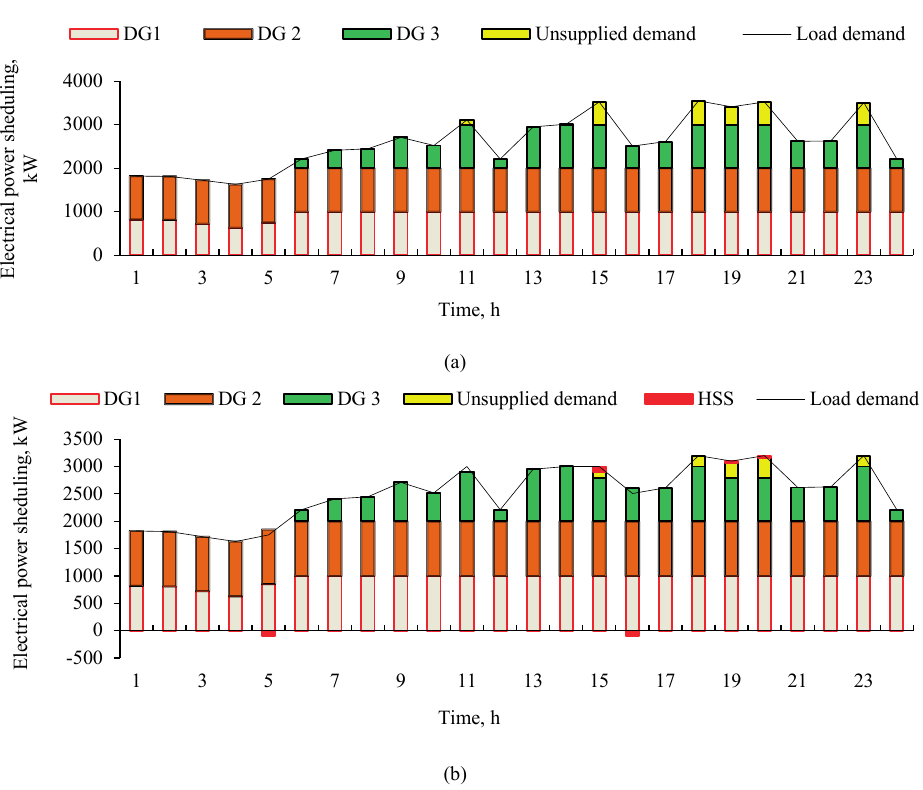
Fig. 6. Optimal power scheduling: a) Case A, and b) Case